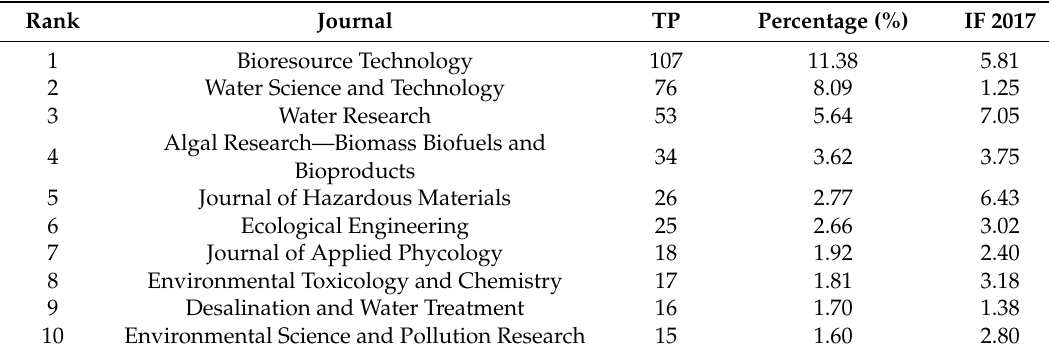
Table 2. The 10 most productive journals during